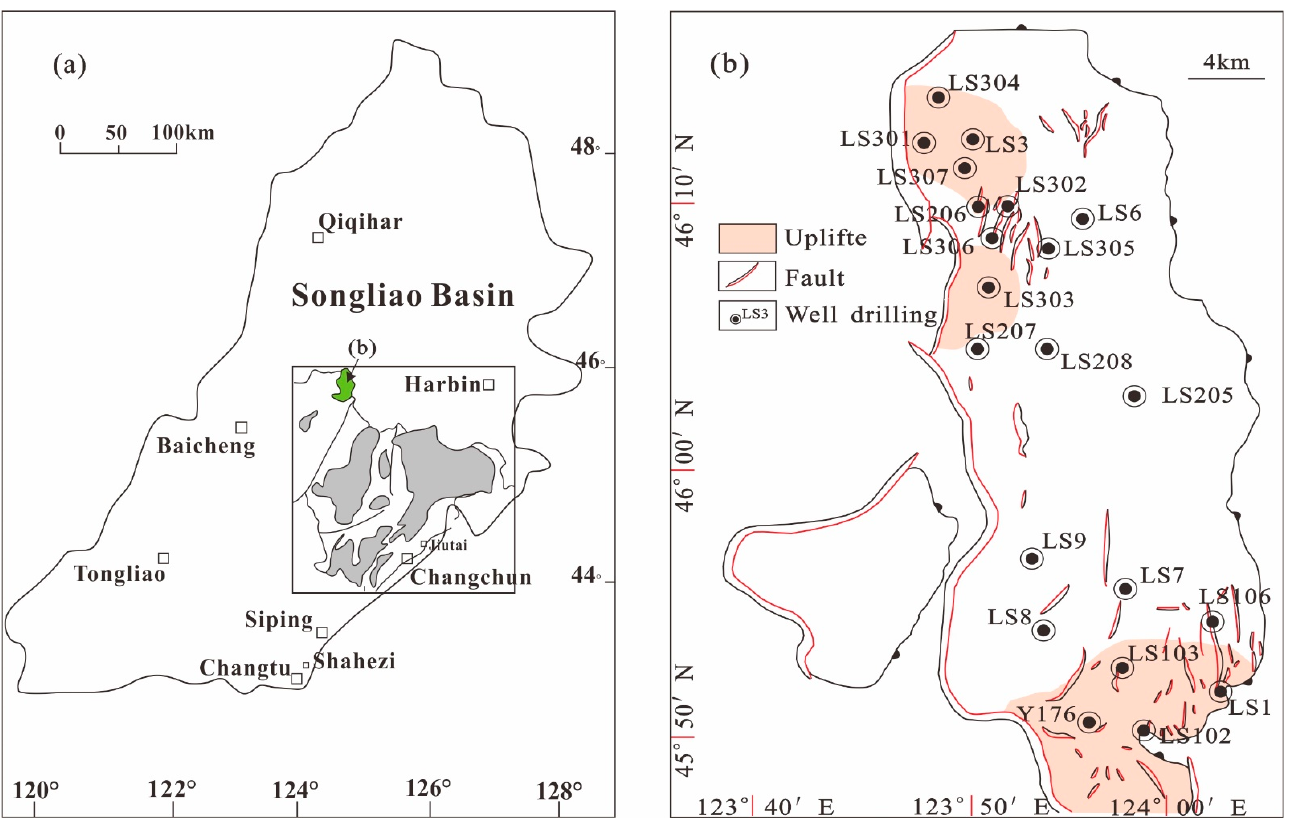
Figure 1. The distribution of wells and research areas. ( a ) The geographic location of YFD in SSB. ( b ) The location of sampling wells and structural characteristics of K 1 y 2 , YFD.